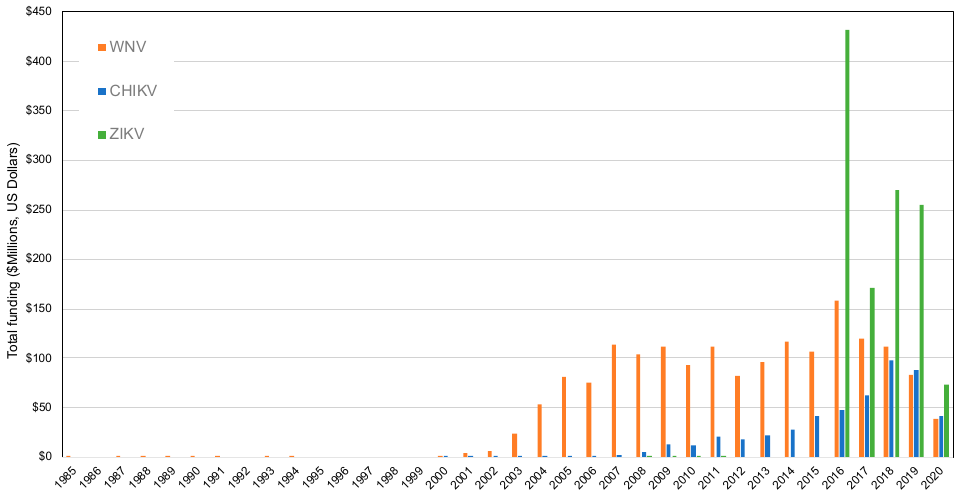
Figure 1. Total funding by the National Institutes of Health based on the National Institutes of Health (NIH) Reporter search query of projects matching West Nile virus (WNV), chikungunya virus (CHIKV), and Zika virus (ZIKV), from 1985 to 2020. Expenditures in 2020 are incomplete as search was conducted on 16 May 2020. Graphed values were corrected for inflation by the Consumer Price Index referenced to 2019 provided by the U.S. Bureau of Labor Statistics.